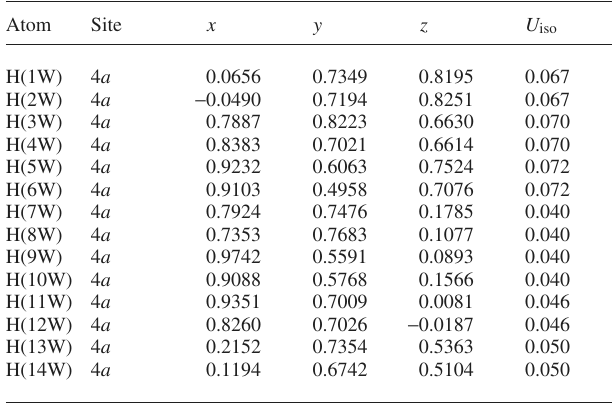
Table 2. Atomic coordinates and displacement parameters (in Å 2 )